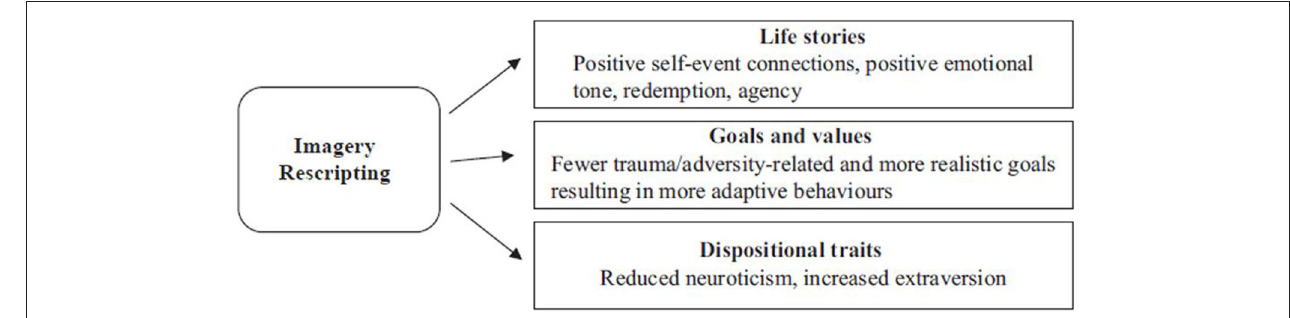
FIGURE 1 | Narrative identity model of change in imagery rescripting. Adapted from Çili and Stopa (36). Copyright 2019 by S. Çili and L. Stopa. Reproduced by permission of Taylor and Francis Group, LLC, a division of Informa